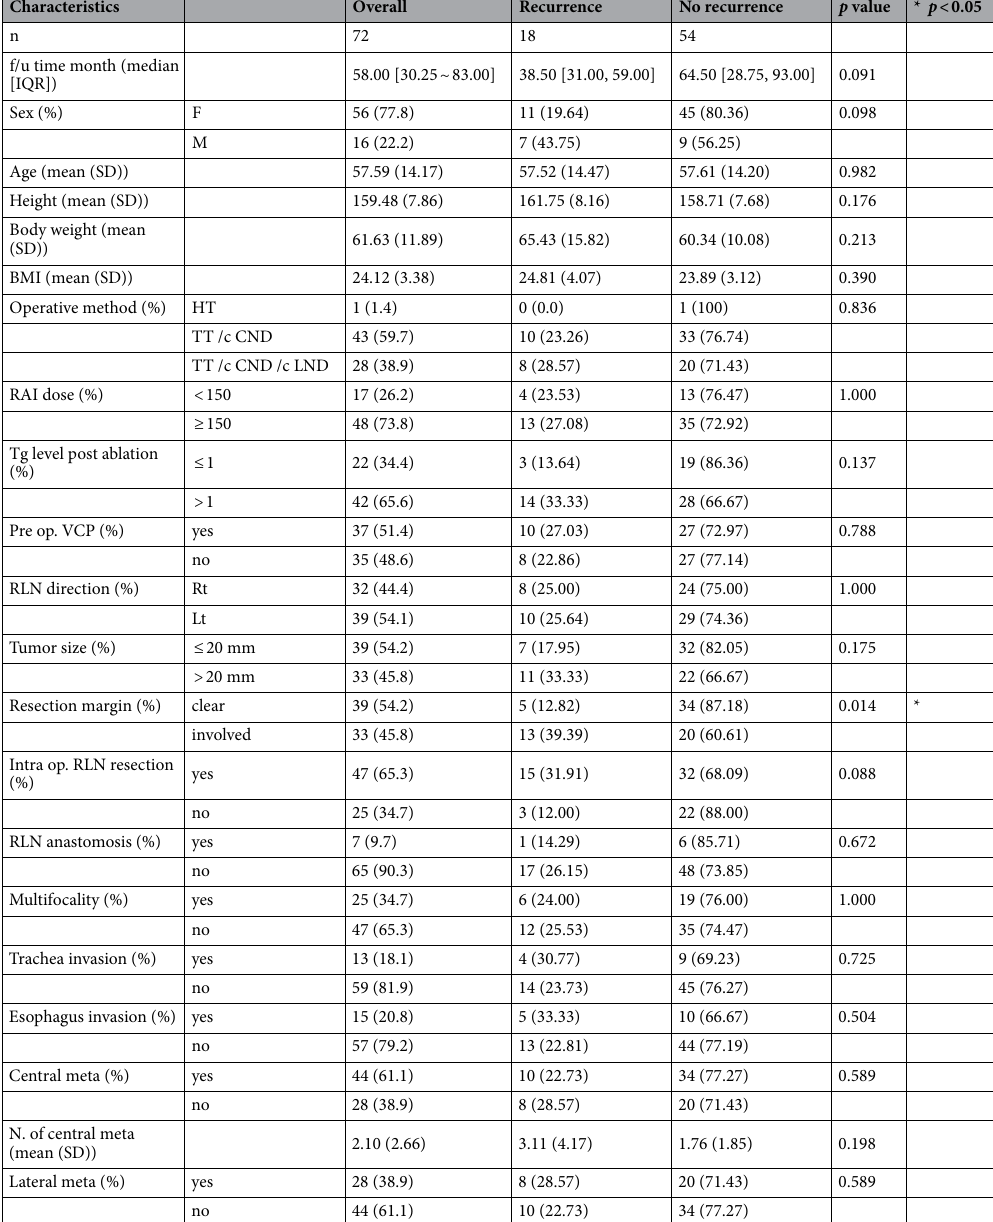
Table 1. Clinical characteristics of 72 patients with RLN invasion. † RLN: Recurrent laryngeal nerve, IQR : Inter quartile range, SD : Standard deviation, RAI : Radioactive iodine, VCP : Vocal cord